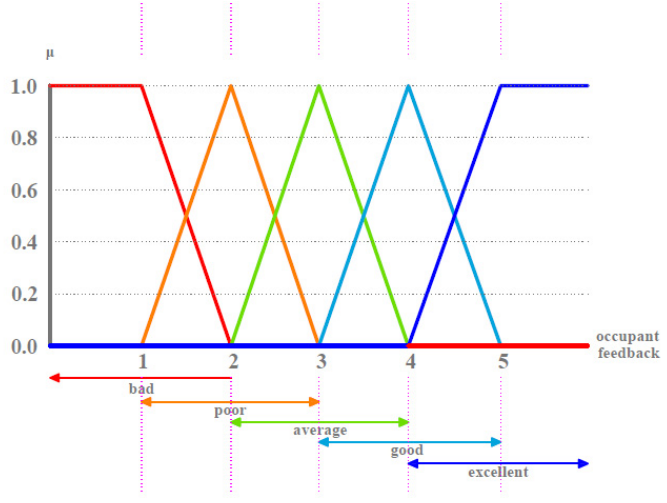
Figure 10. Membership functions of the condition scale for Occupant Feedback.